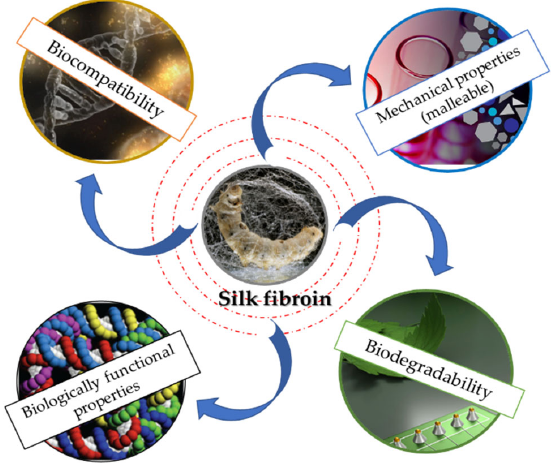
Figure 2. Schematic representation of SF properties.